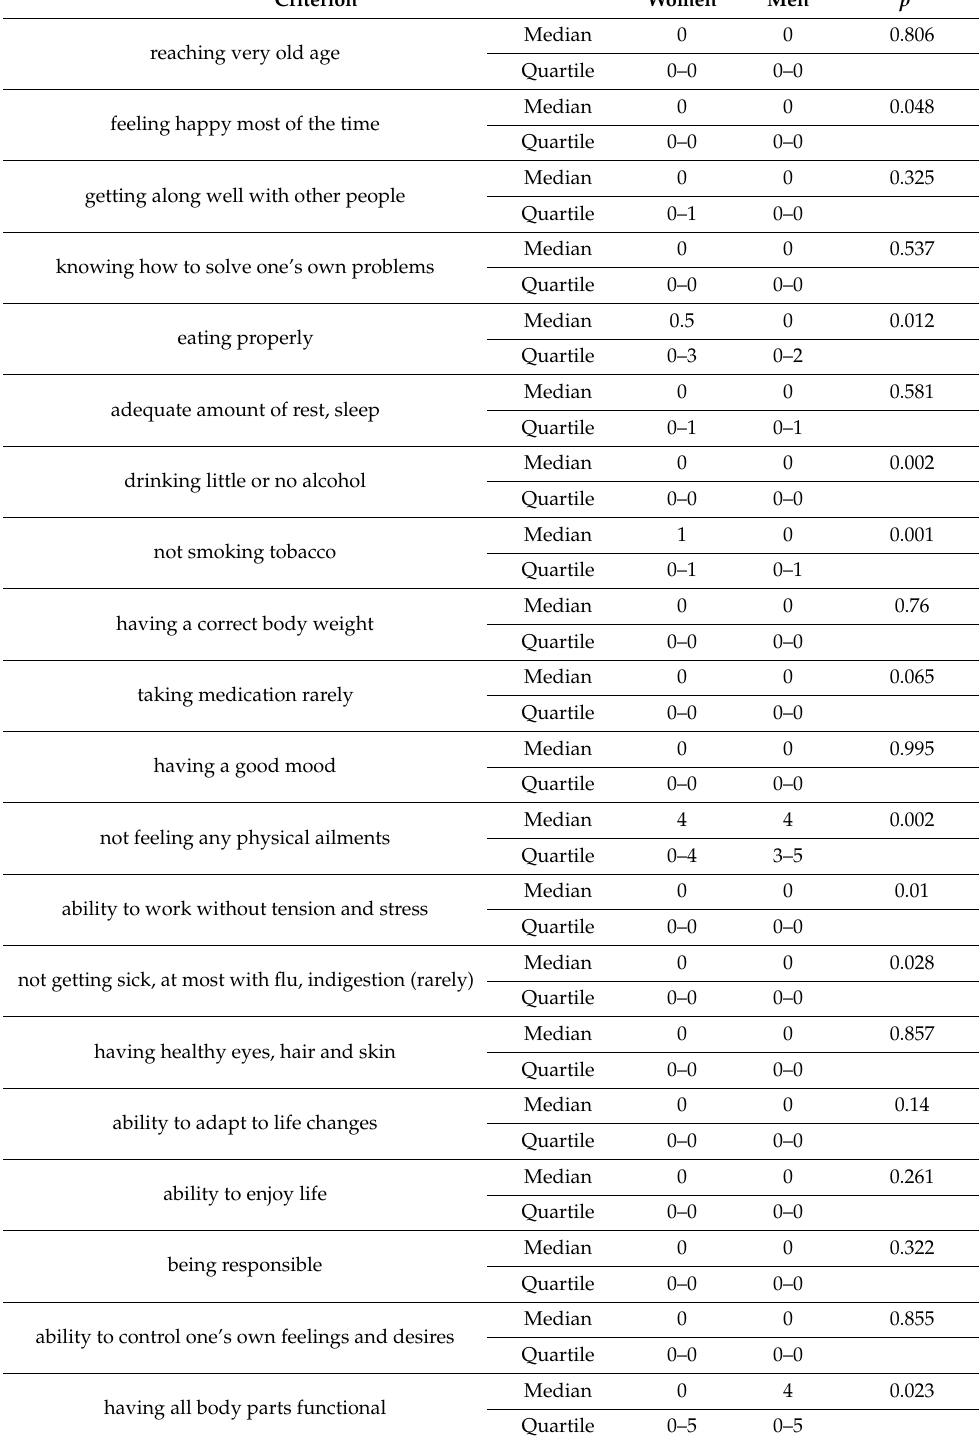
Table 4. Correlations of health statements with the gender of the respondents.